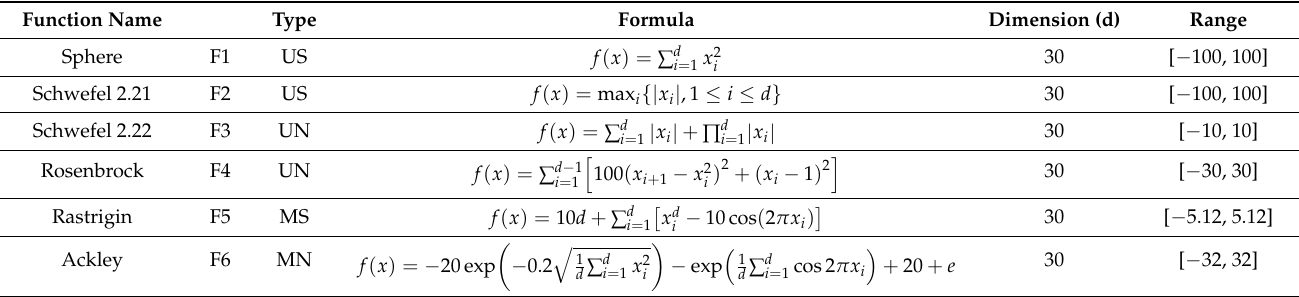
Table 2. Benchmark